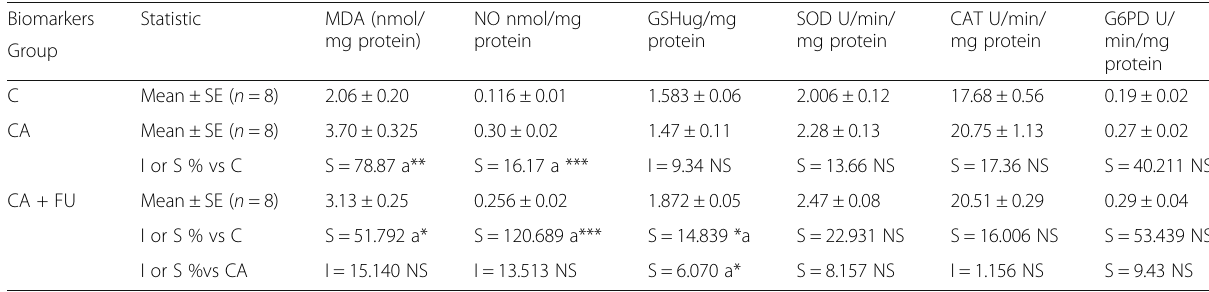
C control group, CA Cyclosporine group, CA + FU cyclosporine + fucoidan group. The significant difference between groups was judged by ANOVA. a: significance difference between the groups, * p <0.05; ** p <0.01; *** p <0.001; NS non-significant, (vs C): percentage of difference with control group, (vs CA): percentage of difference with cyclosporine A group. I inhibition, S